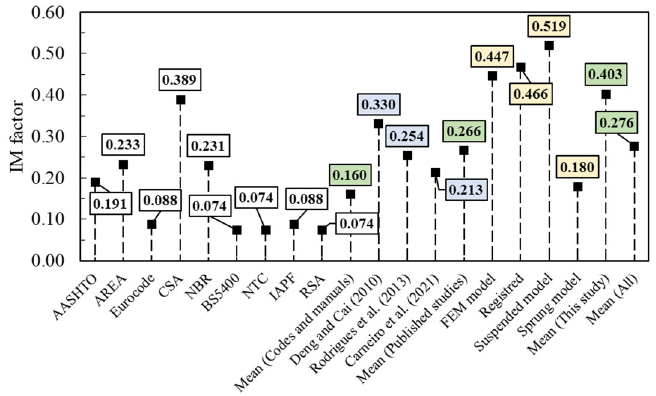
Figure 14. IM factors for several